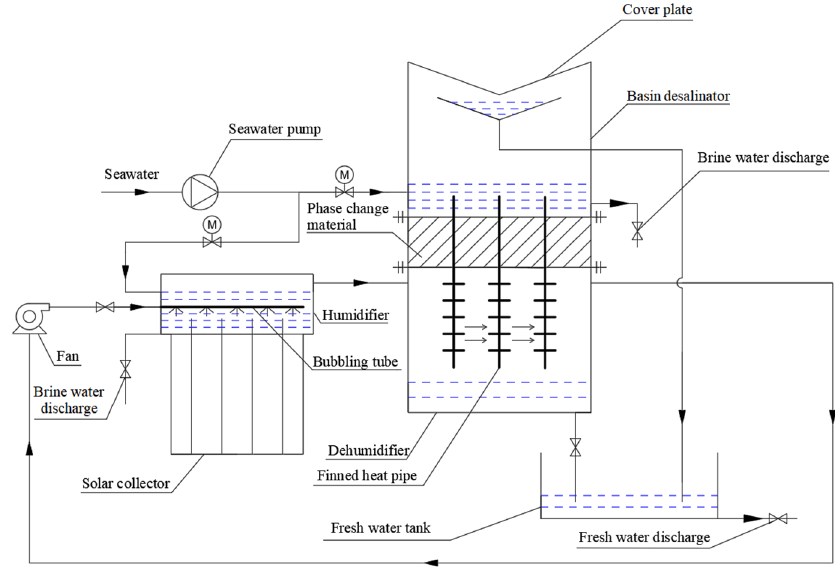
Figure 1. Process diagram of integration HDH solar desalination.